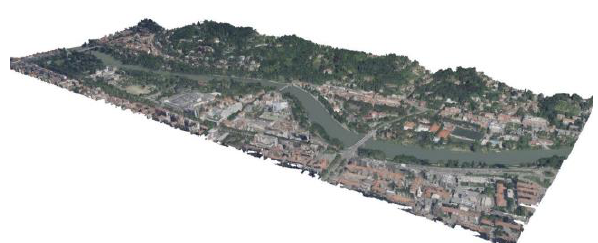
Figure 1. A view of the textured mesh of current state of the Valentino Park and its surroundings obtained with the aerial photogrammetric acquisition